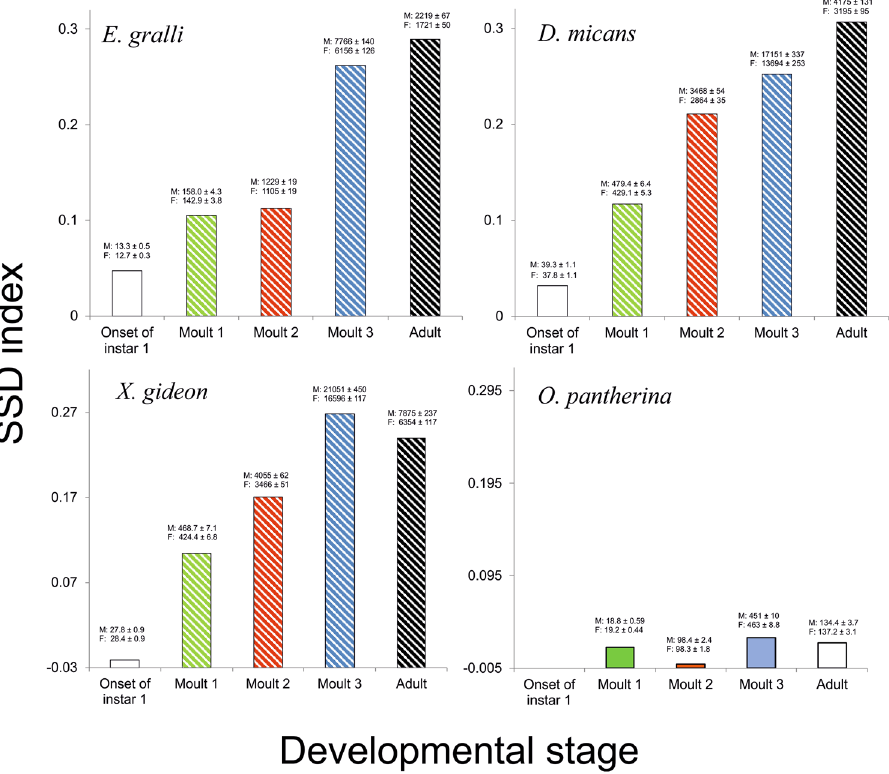
Figure 3. Development of SSD in four scarab species. Shaded bars indicate significant differences in body mass, blank bars indicate non-significant differences. Mean maximal body mass ± SE achieved by males and females in each instar are given above the respective